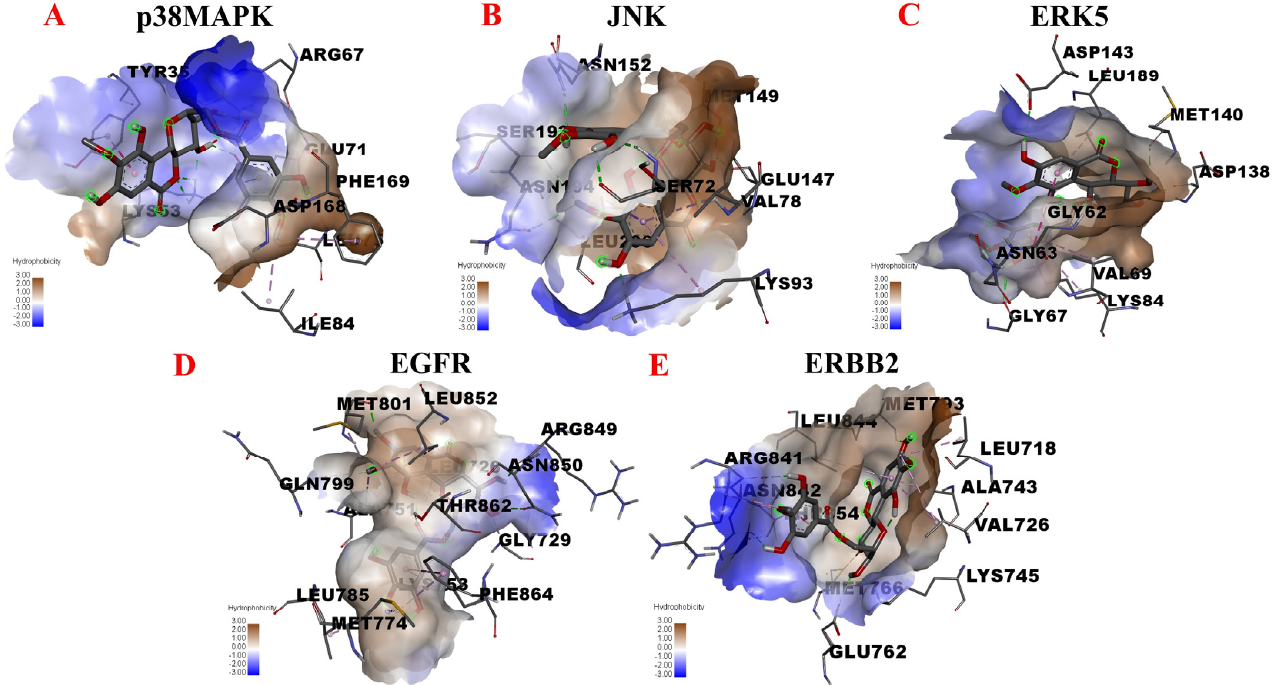
Figure 6. Molecular docking analyses of the putative binding between 11-O-(4’-O-methylgalloyl)- bergenin and p38 MAPK, JNK, ERK5, EGFR, and ERBB2. ( A – E ) correspond to the binding models for interactions between 11-O-(4’-O-methylgalloyl)-bergenin and p38 MAPK, JNK, ERK5, EGFR, and ERBB2, respectively. Hydrophobic interactions are displayed as a colored surface. Table 2. Intermolecular interactions between Fr11 and p38 MAPK, JNK, ERK5, EGFR, and ERBB2.